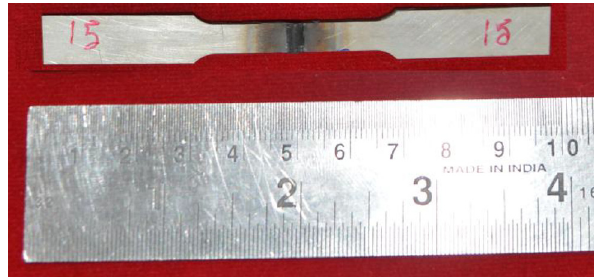
Figure 7: Schematic diagram showing the tensile test